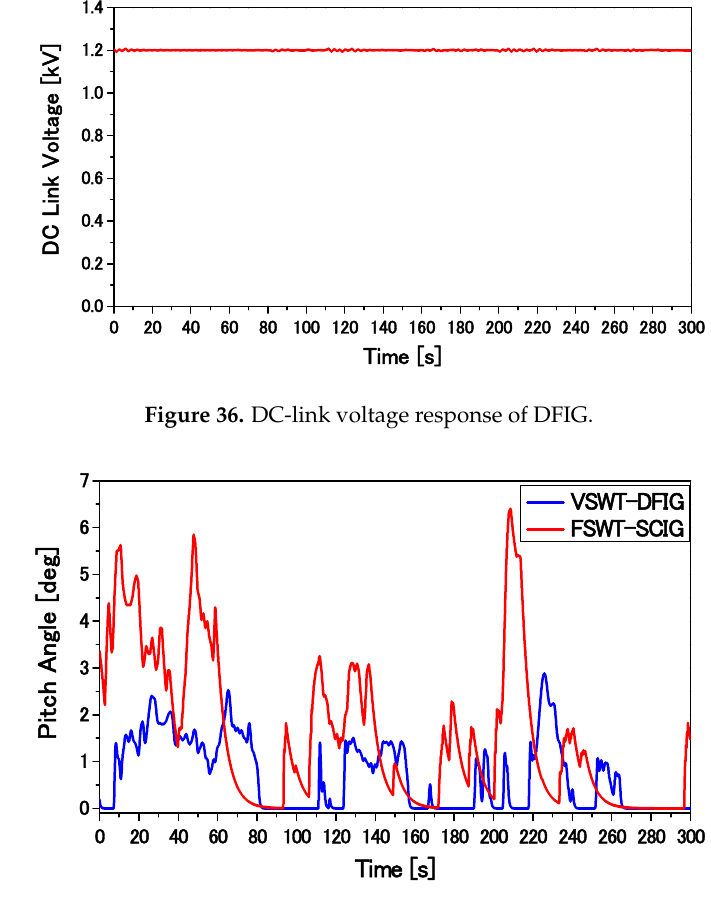
Figure 37. Pitch angle of wind generators.